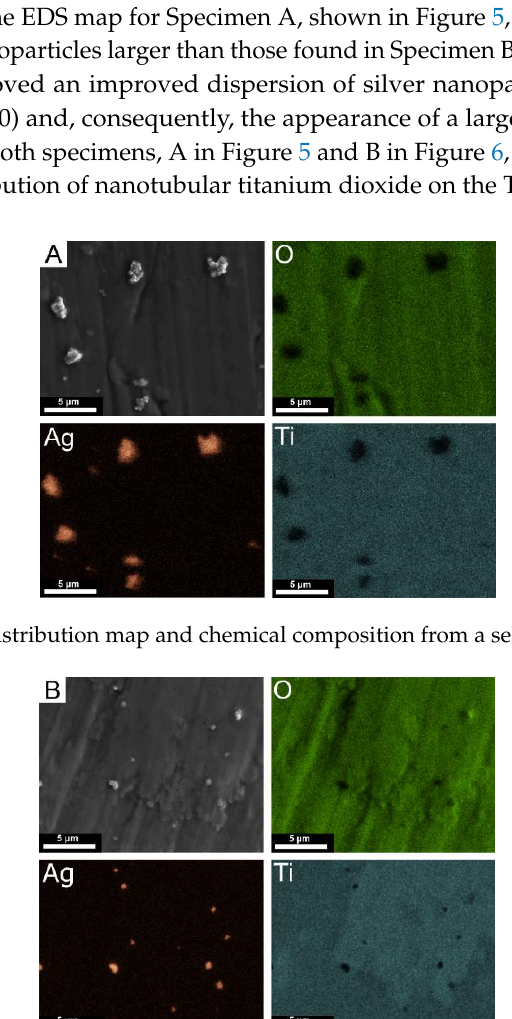
Figure 4. Chitosan composite coatings on TiO 2 on Ti13Zr13Nb. Three different parts of chitosan coating are shown in subfigures; arrows indicate one of the coating interfaces.